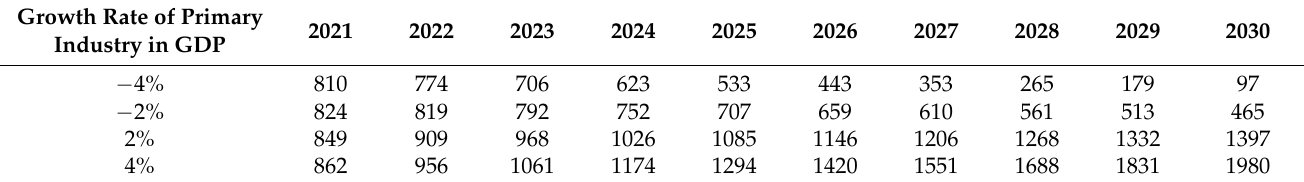
Table 10. Predicted power consumption of the primary industry under different growth